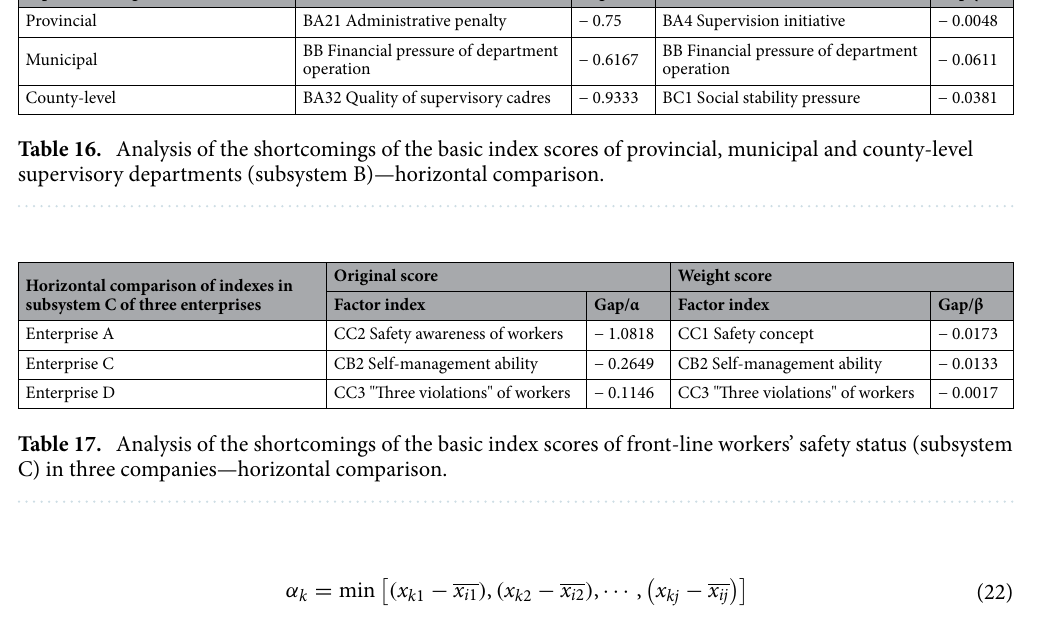
Horizontal comparison of supervision departments